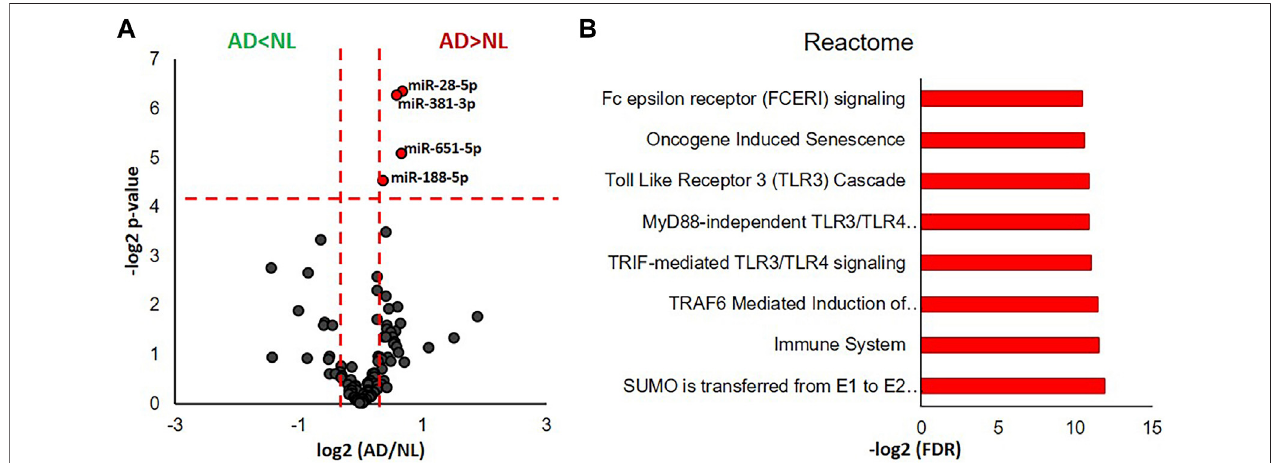
FIGURE 3 | miRNA transcriptomic analysis of microglial EVs from normal/low pathology and late-stage AD cases. (A) Volcano plot showing a degree of differential expressionofmiRNAsinNLandADgroups.VerticalreddottedlinesseparatemiRNA,whichare1.5ormoretimeslessabundantinAD(farleftsegment)and1.5ormore timesmoreabundantinAD(farrightsegment).Horizontalreddottedlineseparatesthetopsectionoftheplotcontainingdotsrepresentingproteinswhoseabundanceis signi fi cantlydifferentbetweenNLandADgroups(* p < 0.05).MicroRNAs,whicharesigni fi cantlydifferentbetweenADandNLgroups,arecolor-coded:1.5ormore times more abundant in AD are presented in red, 1.5 or more times less abundant are in green. (B) Gene ontology enrichment bioinformatic analysis of miRNAs signi fi cantly more abundant in AD compared to